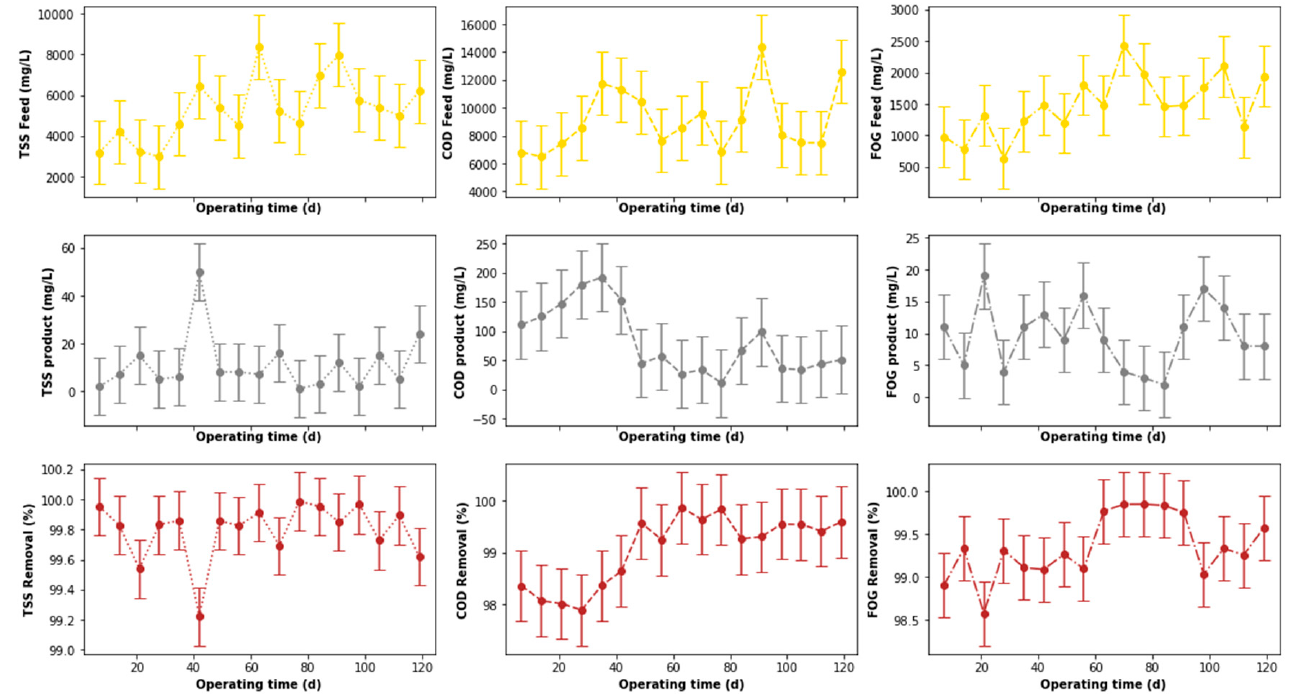
Figure 23. Overall performance of the combination of the pre-treatment stage, the DEGBR, and the MBR.